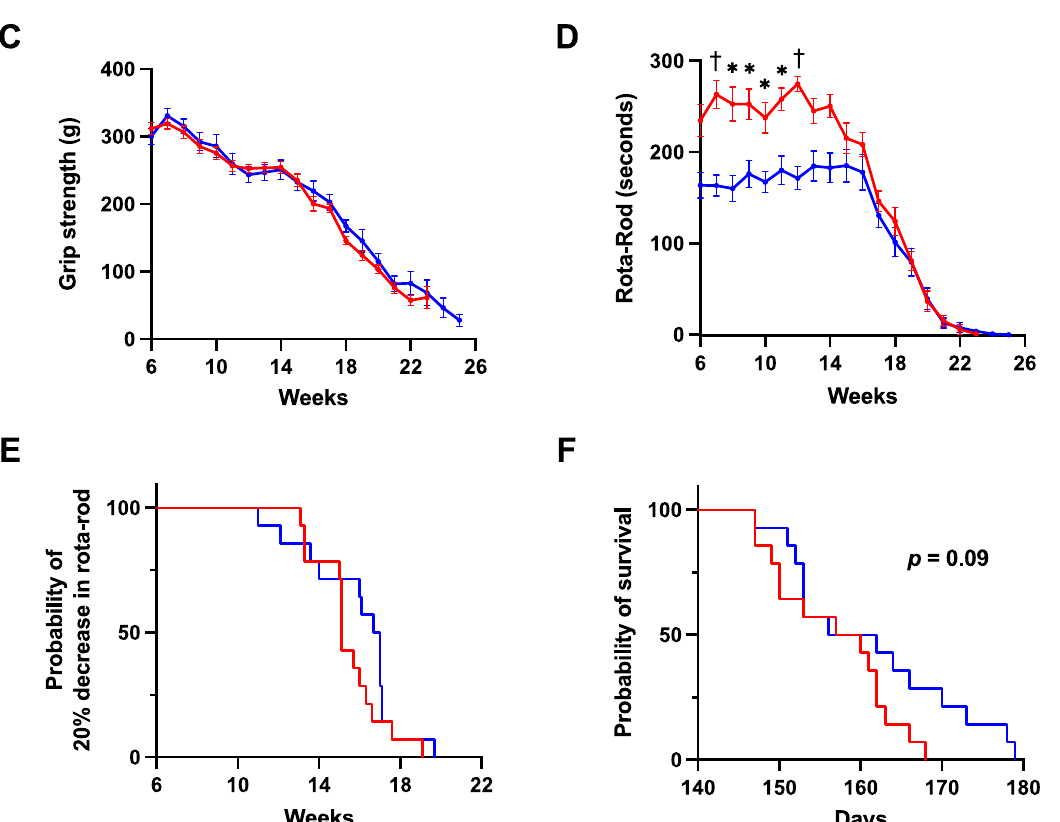
Figure 2. Phenotypic features of Cx30 KO-mSOD1 mice and mSOD1 mice. ( A ) Symptom-free survival curve, ( B ) ALS-TDI score, ( C ) grip strength, ( D ) rotarod test, ( E ) curve of the decline in rotarod test performance, and ( F ) survival curve ( Cx30 KO-mSOD1 mice and mSOD1 mice, n = 14). Red and blue lines indicate mSOD1 and Cx30 KO-mSOD1 mice, respectively. Means and SEM are shown. The Gehan − Breslow − Wilcoxon test was used to statistically compare the timing of onset as the timing of body weight peak. Multiple t-tests were used to statistically compare ALS-TDI scores, grip strength data, and rotarod test data. The log-rank test was used to compare declines in rotarod test performance and survival time ( p = 0.22 and 0.09, respectively). * p < 0.05 and † p < 0.001.